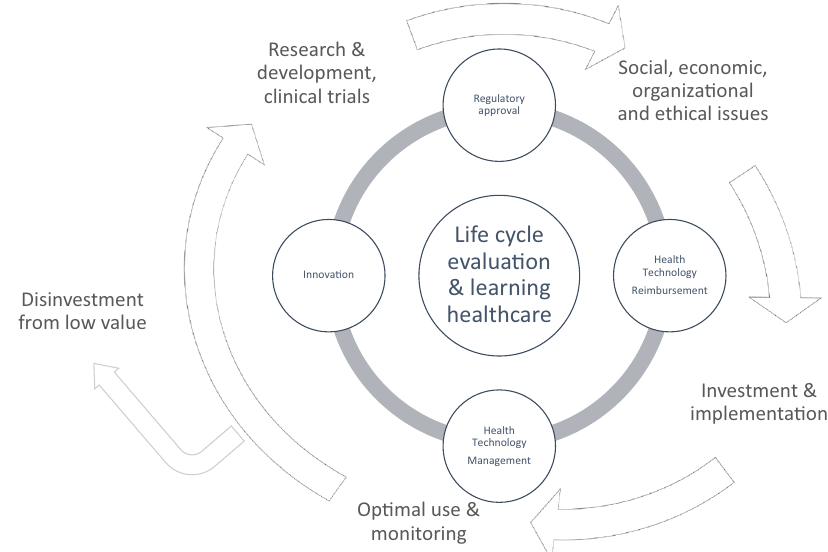
Fig. 1 Stages of the technology life-cycle and learning healthcare. Life-cycle stages of drugs include: drug discovery and development (innovation), preclinical and clinical research, regulatory approval based on safety and ef fi cacy, health technology assessment (investment, implementation), health technology management (optimal use), and disinvestment from low-value technologies. Learning healthcare generates and applies evidence to improve patient health; drive discovery as a result of data from patient care; and ensure innovation, quality, safety, and value for money in